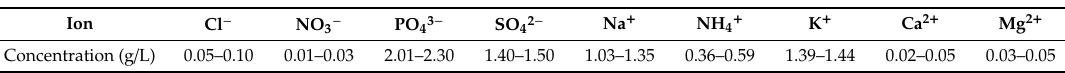
Table 4. The ions concentration in 1,3-PD post-fermentation solutions with Citrobacter freundii bacteria. Ion Cl − NO 3 − PO 43